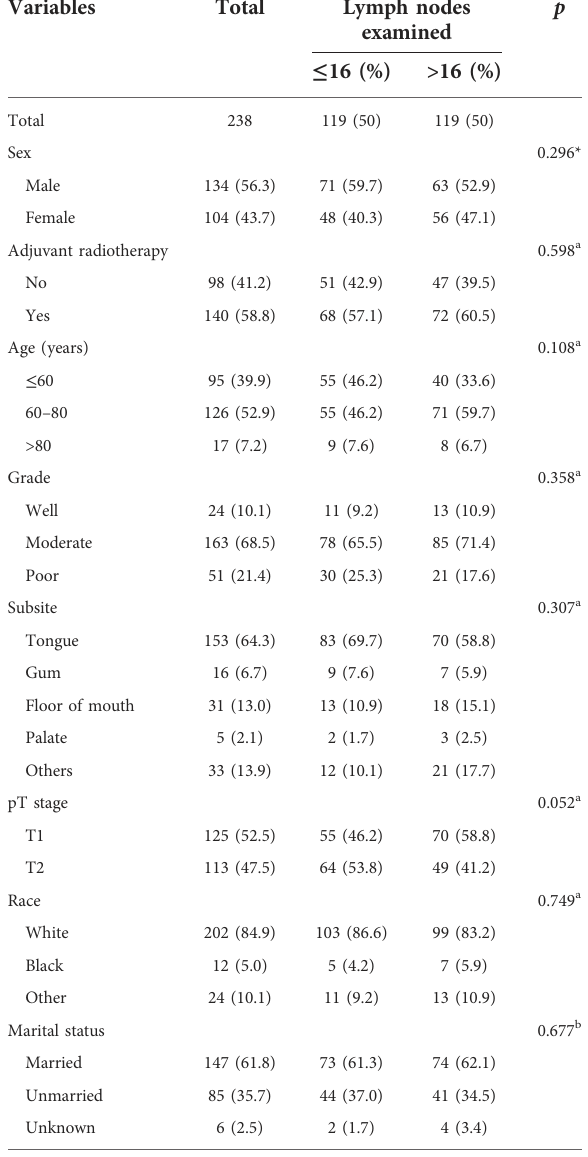
TABLE 1 Associations between lymph nodes examined and clinicopathological characteristics of OCSCC patients (after PSM). Variables Total Lymph nodes